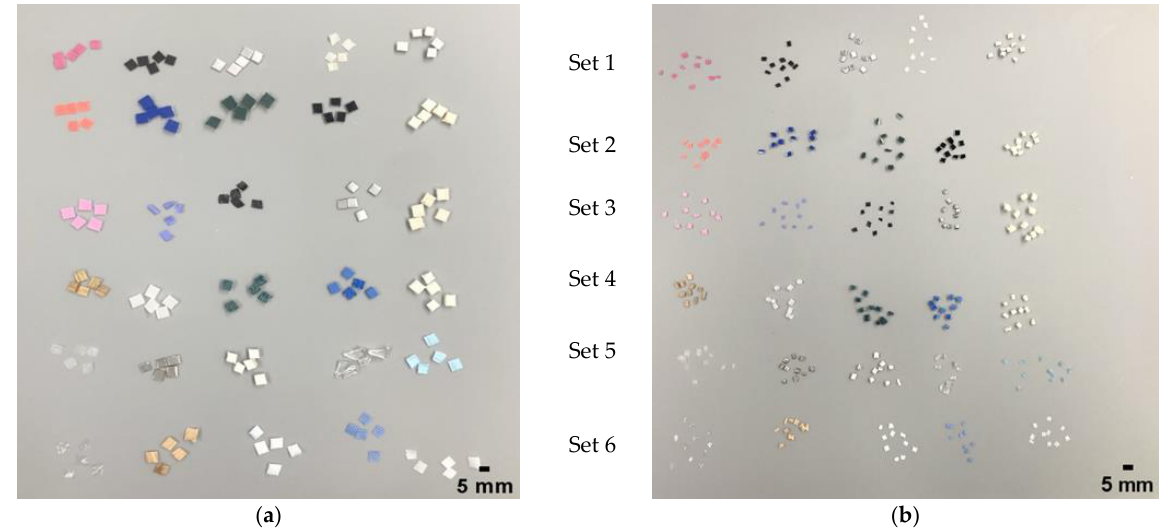
Figure 1. Pictures of all FM samples used in this study: ( a ) 5 × 5 mm 2 size and ( b ) 2 × 2 mm 2 size of FMs. The information about the samples in the pictures is in Table 1, while the samples within a set (Set 1–6) were placed from left to right along a row in the pictures, they were listed from top to bottom in the table.